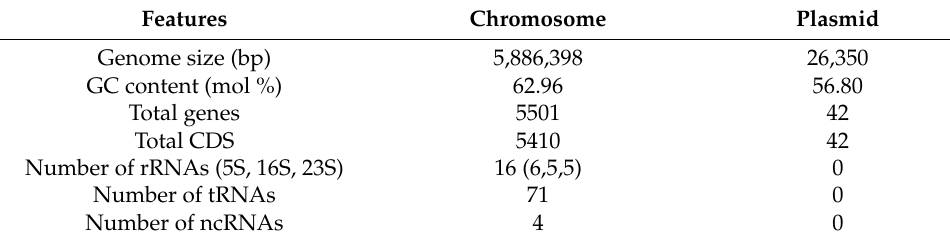
Table 1. Features of Pseudomonas sp. DY-1